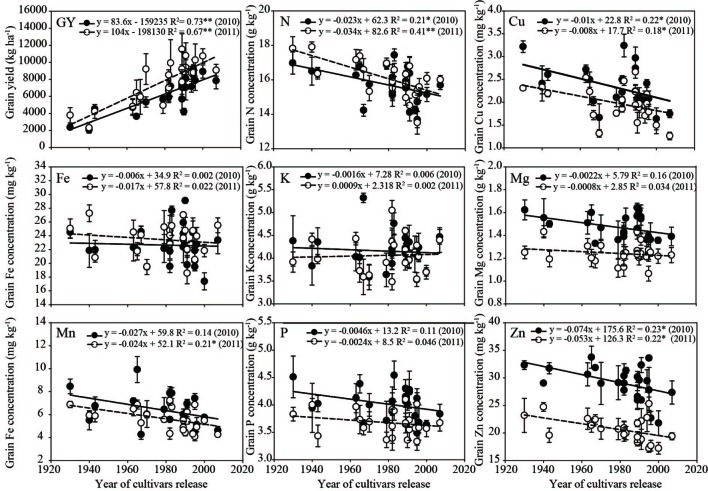
Relationship between the year of cultivars release, grain yield, and grain nutrient (N, Cu, Fe, K, Mg, Mn, P, and Zn) concentrations. Data were collected in Shun-Yi (SY). Closed and open circle denote the mean ± SD of three and four replicates in 2010 and 2011, respectively. *, ** denote significance at the 0.05 and 0.01 probability levels, respectively; NS, not significant (P > 0.05).